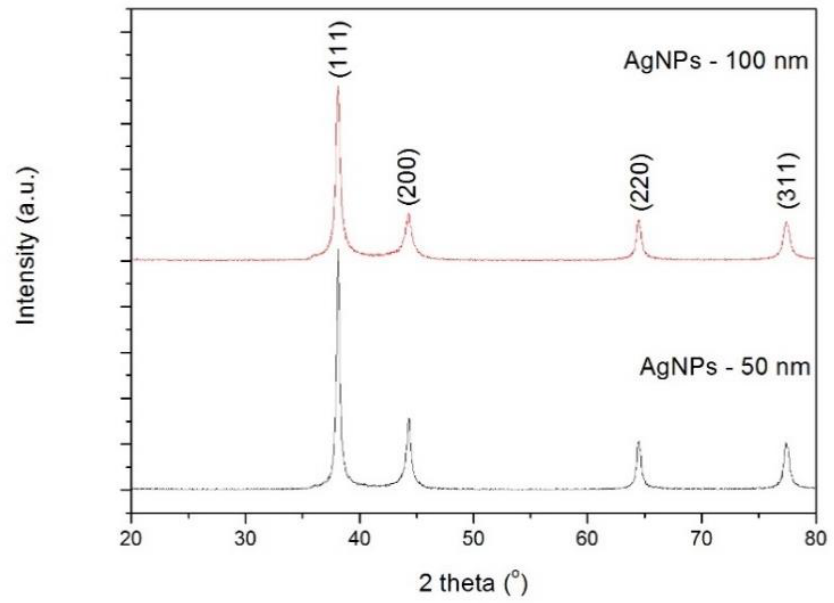
Figure 1. X-ray diffraction patterns of silver nanoparticles (Ag NPs). Figure 1. X-ray di ff raction patterns of silver nanoparticles (Ag